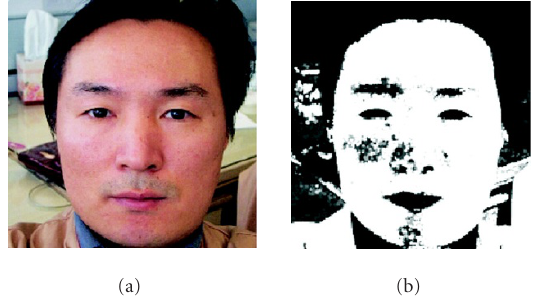
Figure 2: Typical skin detection examples. (a) Input image. (b) Detected skin pixels marked in